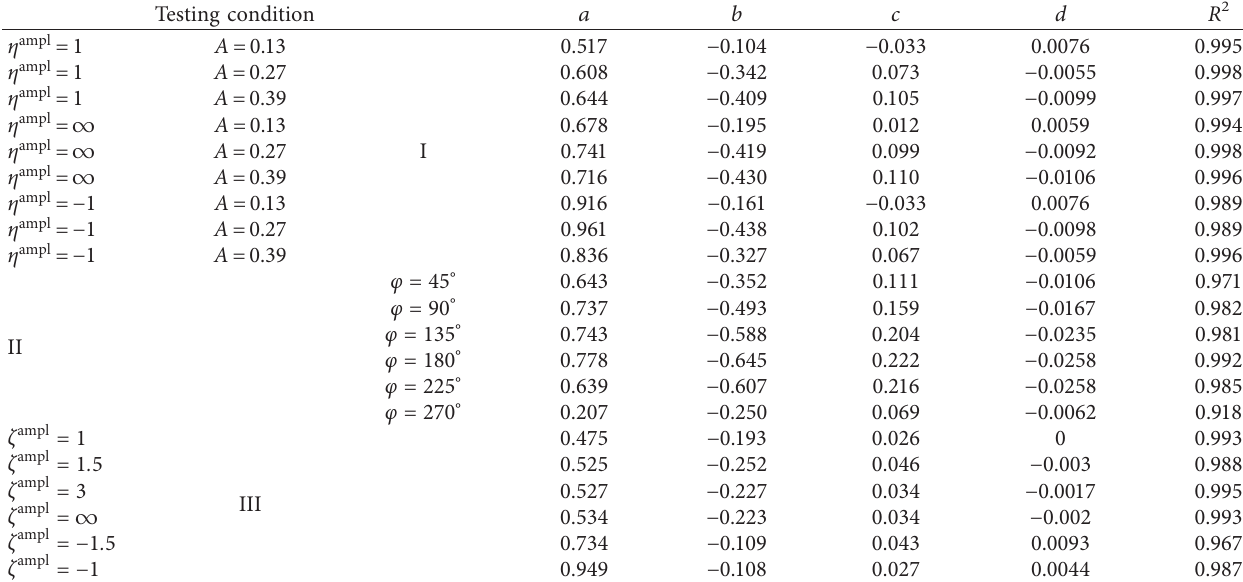
Table 5: Fitting parameters and R 2 of damping ratio under various dynamic stress paths.